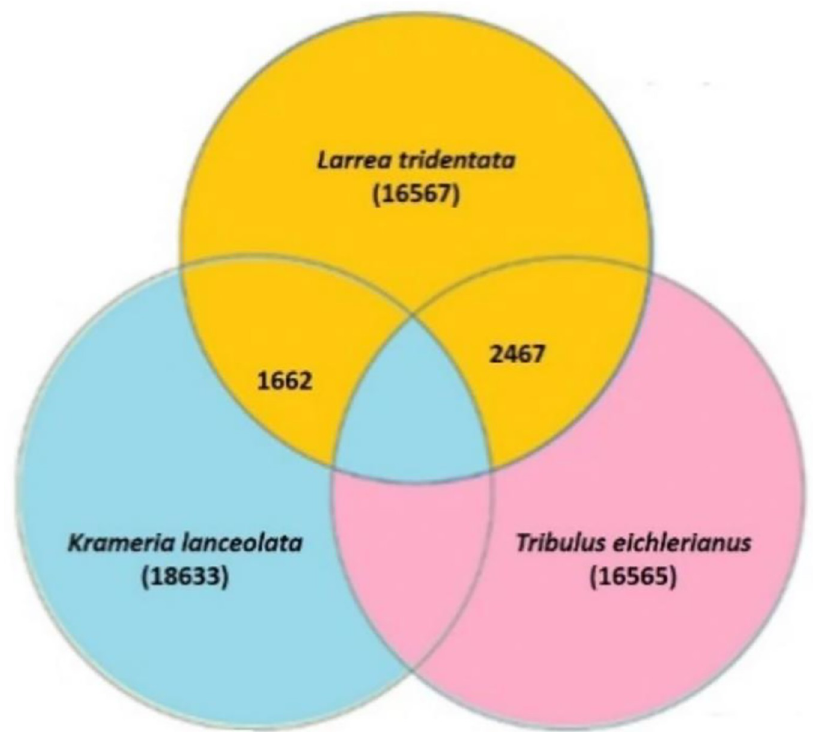
Fig 2. Distribution of the orthologous genes in L . tridentata , and two other transcriptomes of the members of order Zygophyllales, K . lanceolata (family Krameriaceae ex. Zygophyllaceae) and T . eichlerianus (family Zygophyllaceae).